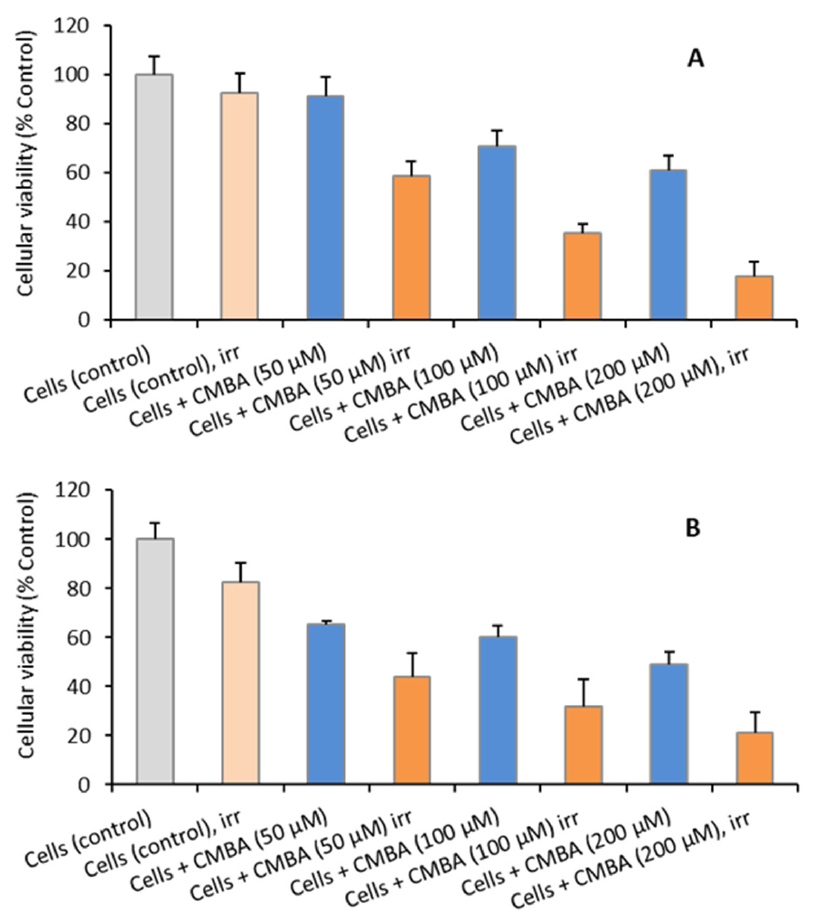
Figure 8. Cellular viability (%) of U87 cells after neutron irradiation ( A ) 24 h and ( B ) 72 h. Cells or cells previously incubated with CMBA at 50, 100, and 200 µ M were irradiated at room temperature for 5 h at a nominal thermal neutron fluence rate of 6.6 × 10 7 n cm − 2 s − 1 , at 1 MW. Results are mean ± SD of 2 independent experiments with at least 4 replicates.